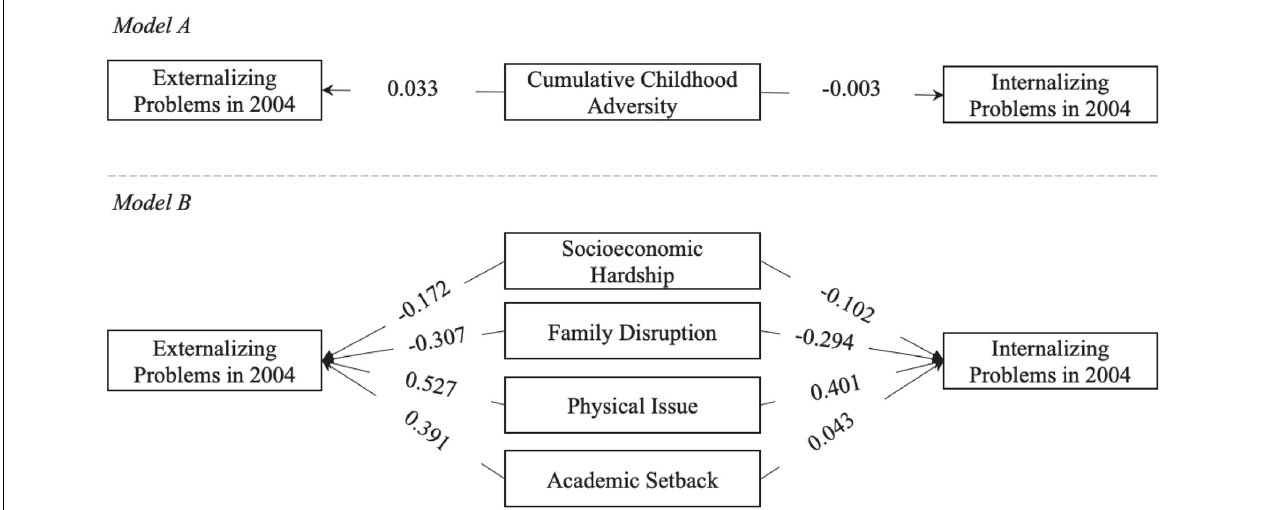
FIGURE 3 | Illustration of the associations between childhood adversity and childhood mental health in adolescence. Age and gender are not shown in this figure for simplicity. Numbers on arrows are unstandardized regression coefficients. * < 0.05, ** < 0.01, *** < 0.001.